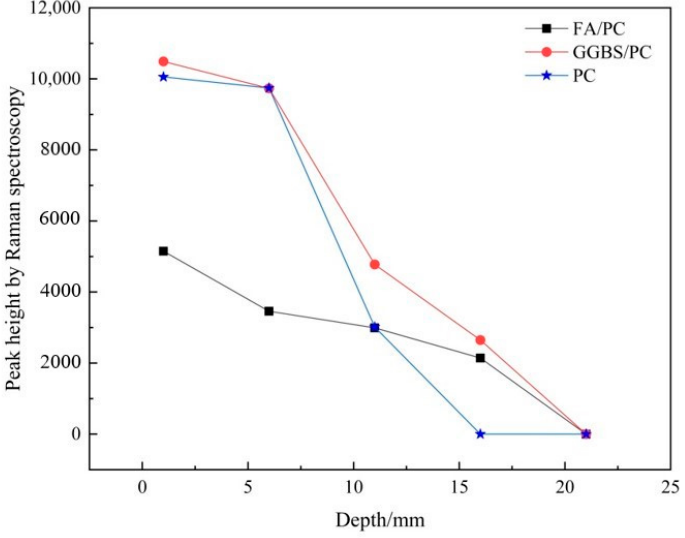
Figure 6. Relationship between the depth and peak height obtained from carbonated FA/PC, GGBS/PC and PC paste samples under Raman